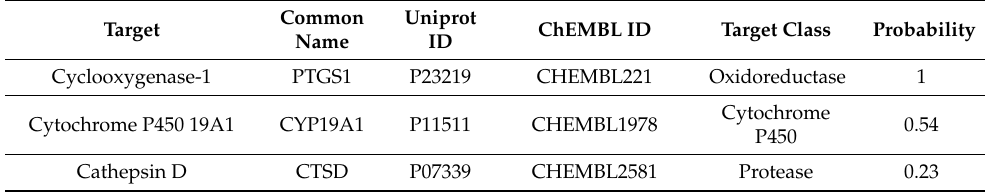
Table 11. Main molecular targets of the phytochemical glutinone obtained through the analysis in Swiss Target Prediction [102].